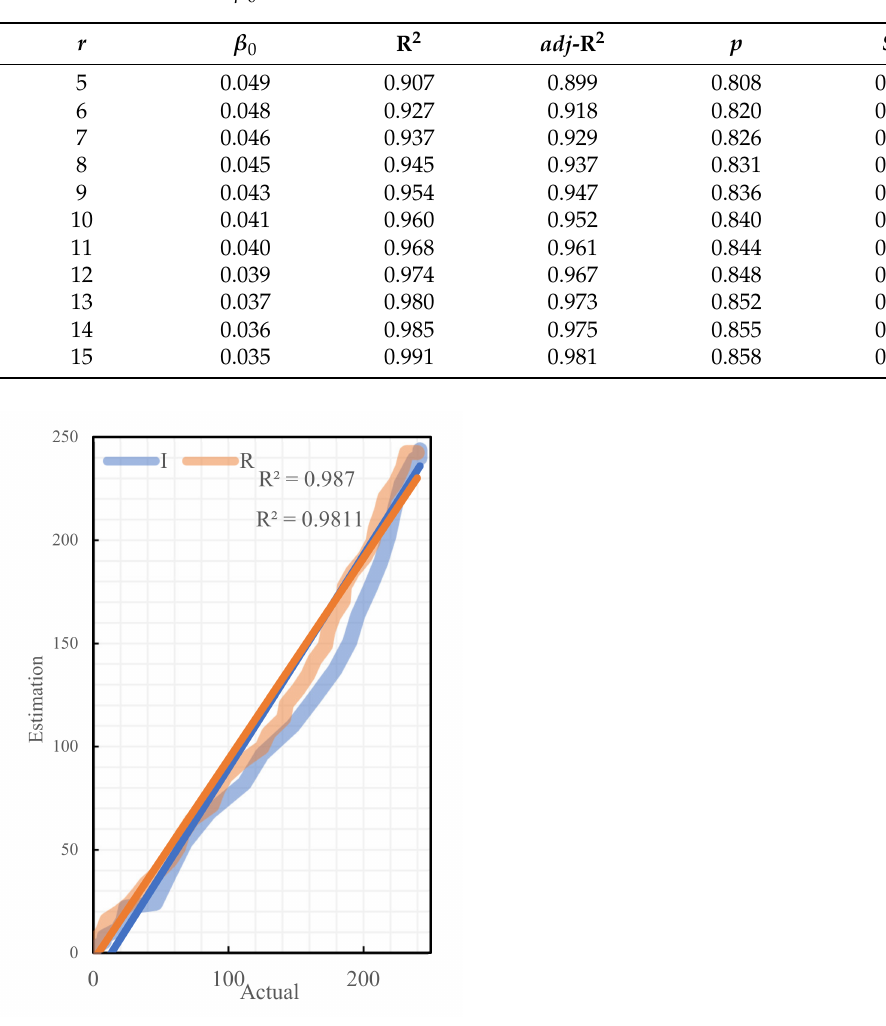
Table 4. The calculated β 0 values for different values of r .